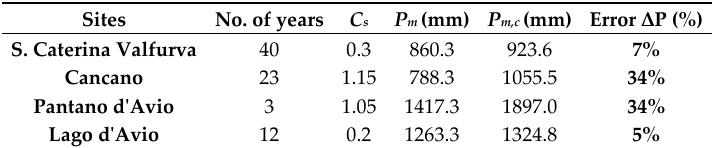
Table 4. Mean yearly precipitation in some monitoring stations before and after the correction model